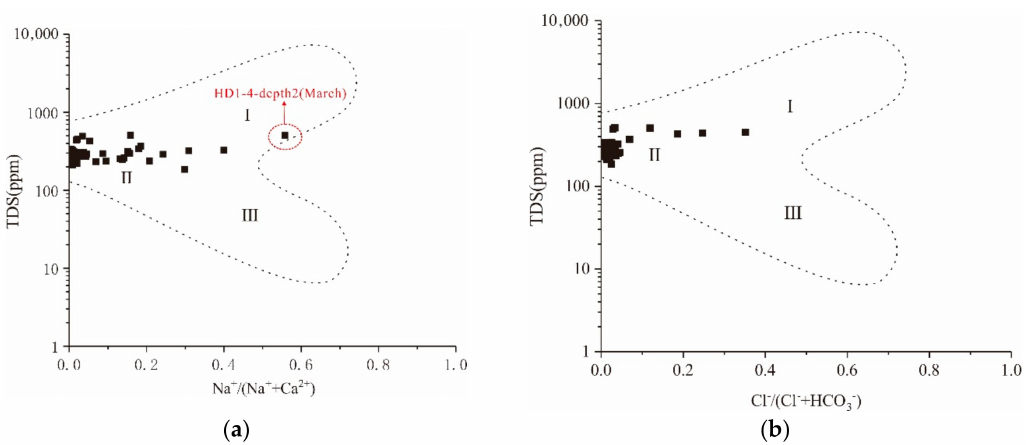
Figure 8. Gibbs graph of karst groundwater in Huanjiang syncline, Guangxi (I: evaporation and concentration; II: rock weathering; III: meteoric